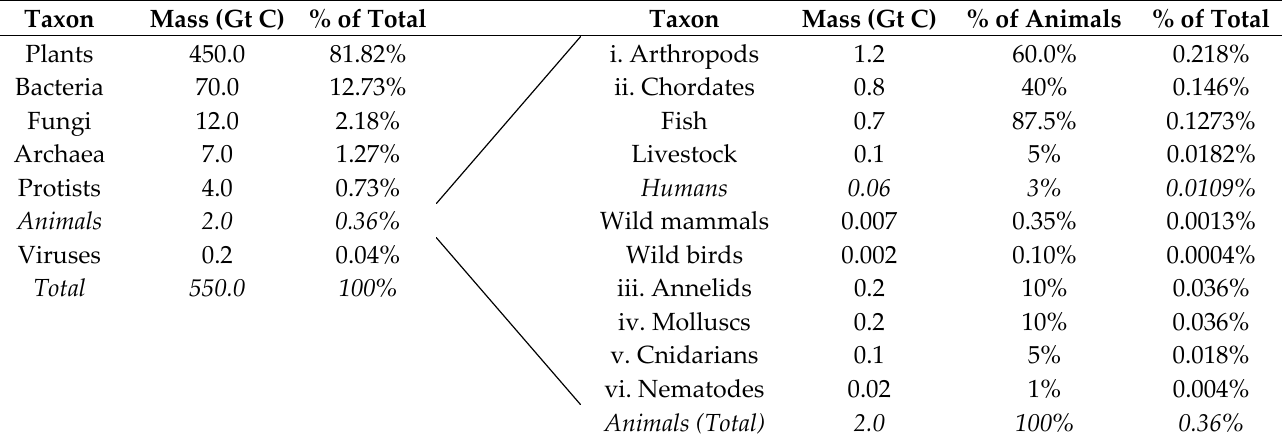
Table 2. Summary of est. total biomass for abundant taxonomic groups on Earth. Adapted from [25].